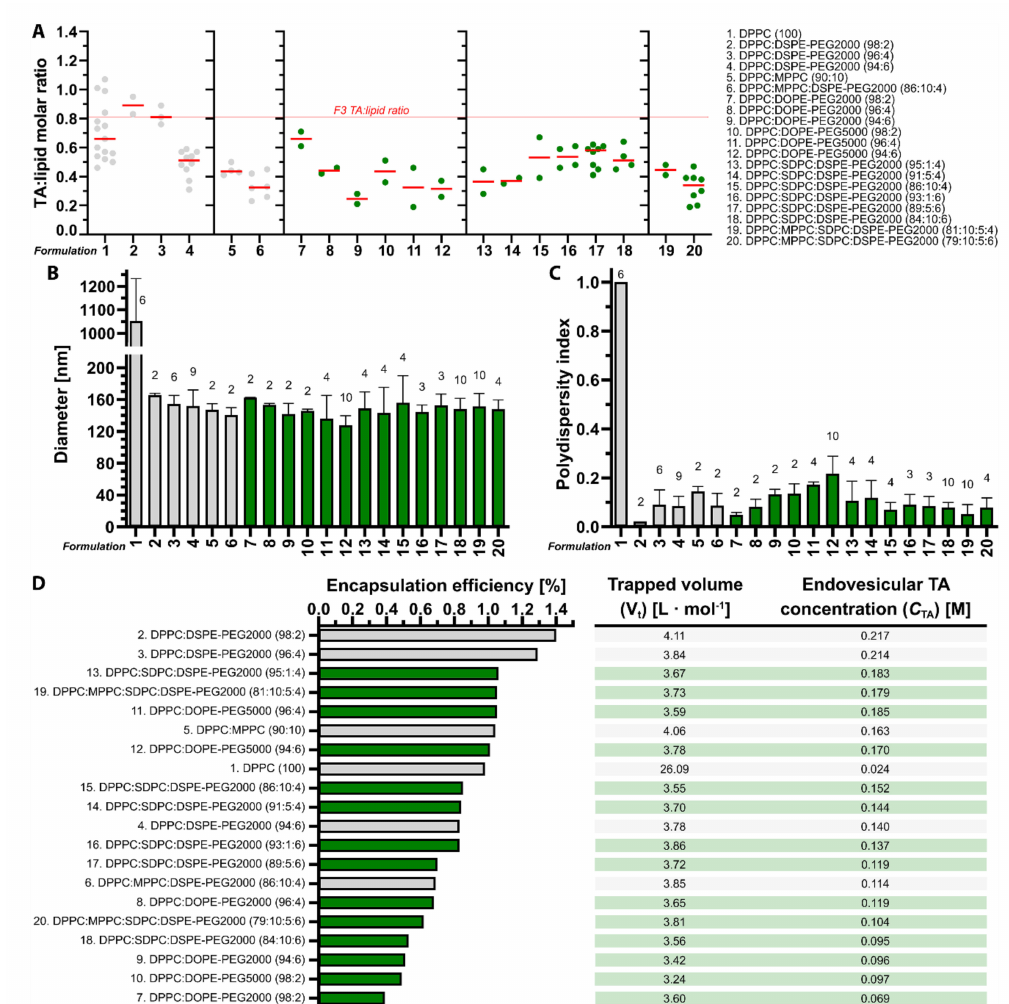
Figure 2. Physicochemical properties of tranexamic acid (TA)-encapsulating liposomal formulations. ( A ) TA:lipid molar ratio plotted per formulation. Dots represent individual experiments and short red lines represent the mean. The protracted red line, corresponding to the mean TA:lipid ratio of DPPC:DSPE-PEG liposomes—the prime candidate formulation for antifibrinolytic SSPLT—was inserted for purposes of comparison. The mean ± SD diameter ( B ) and polydispersity index ( C ) were measured by photon correlation spectroscopy. In ( D ), the encapsulation e ffi ciency was calculated from the measured TA:lipid ratio after size exclusion chromatography in relation to the initial input of TA and lipids. The trapped volume was extrapolated from the mean liposomal diameter as described in Section 2.2. Data in gray have been published previously [16] and were included for purposes of reference and